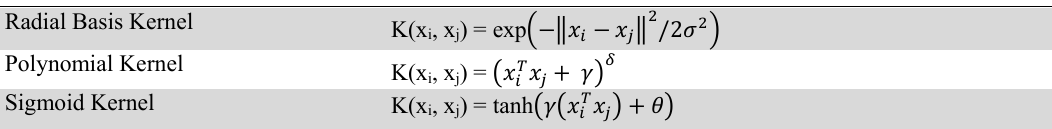
Kernel Functions Radial Basis Kernel K(x Polynomial Kernel K(x Sigmoid Kernel K(x Substituting Eq. (3) and Eq. (5) into Eq. (4), yields the